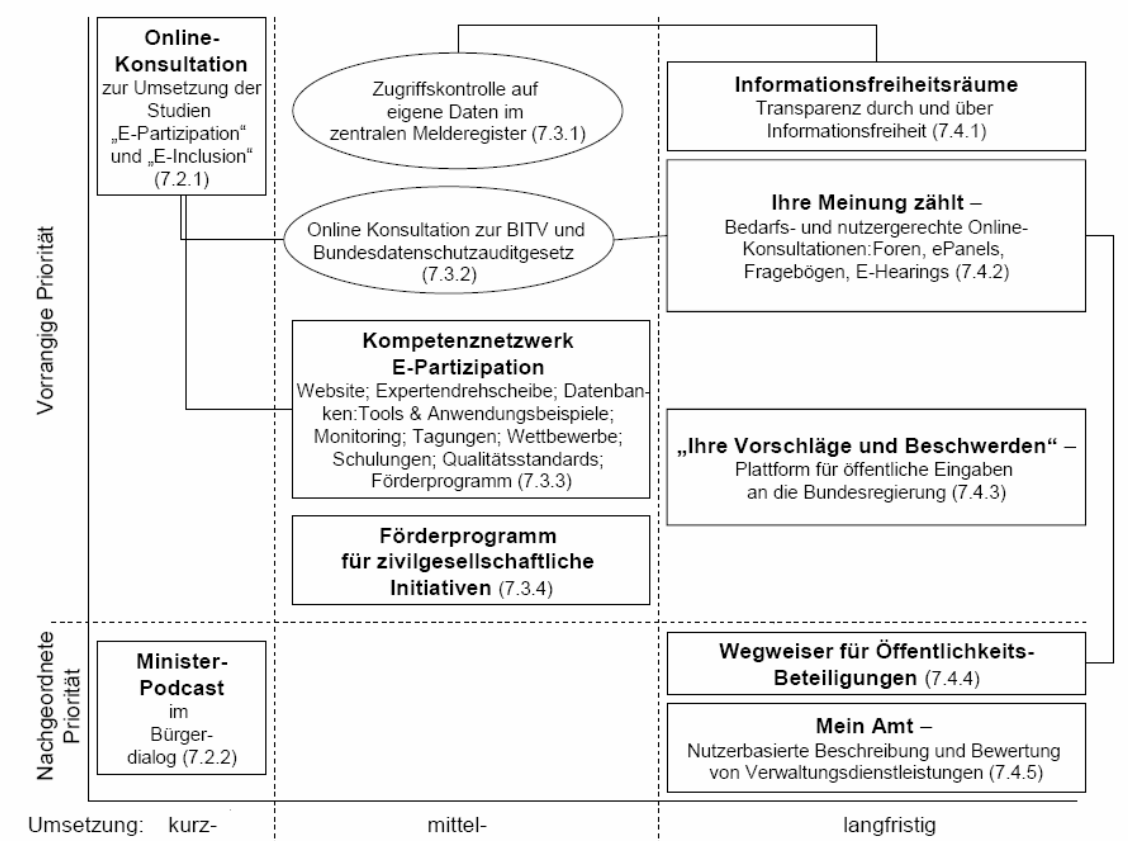
würdigkeit der staatlichen Stellen im Hinblick auf die Ernsthaftigkeit ihres Interesses am demokrati- schen